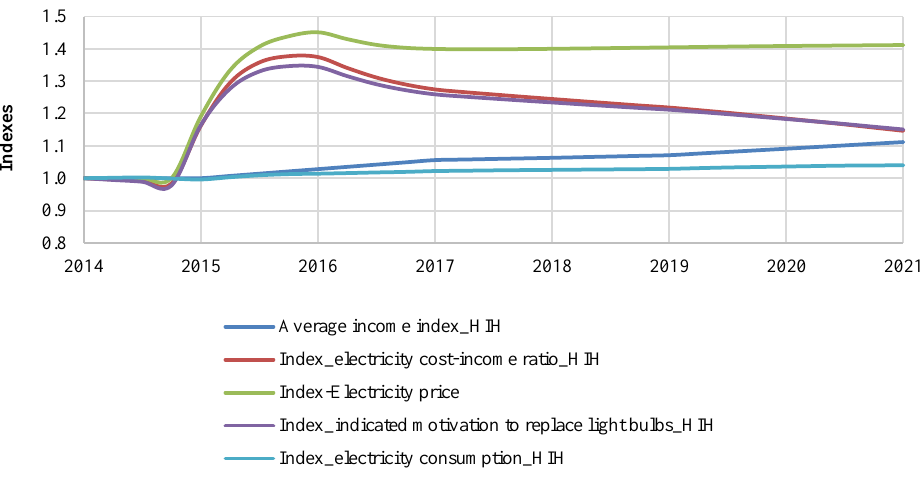
Fig. 11. Indexes of electricity price and high income household (HIH) electricity consumption, average income, electricity cost-income ratio, indicated motivation to replace light bulbs.